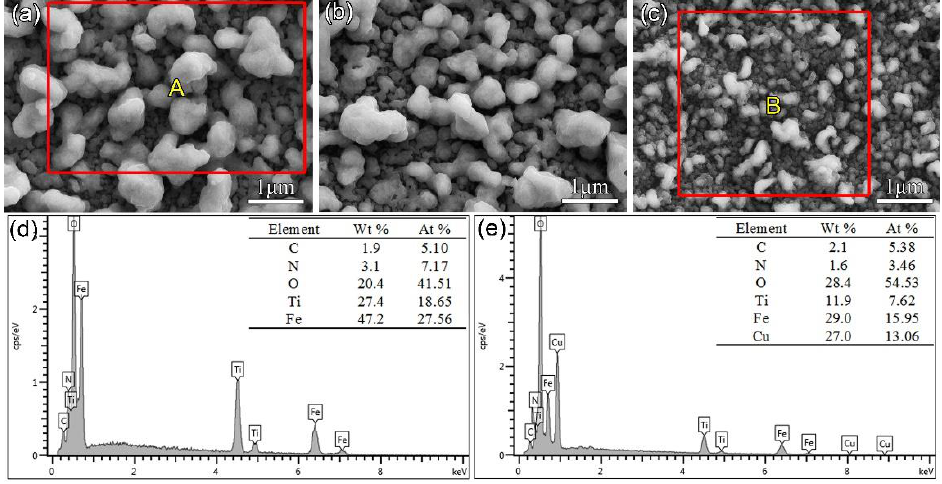
Figure 7. SEM micrographs and EDS results of the fabricated Cu-Ti film on C17200 Cu alloy after plasma nitriding at 650 °C for 4 h: ( a ) F1, ( b ) F2, ( c ) F3, ( d ) EDS result of region A in (a), and ( e ) EDS result of region B in (c).